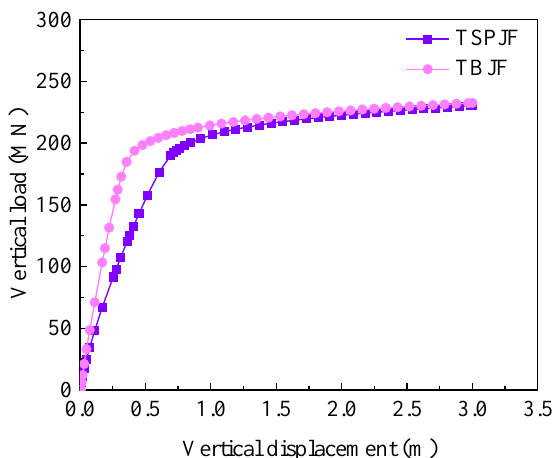
Figure 3. Vertical load – displacement curve of the TSPJF and TBJF at the loading points.